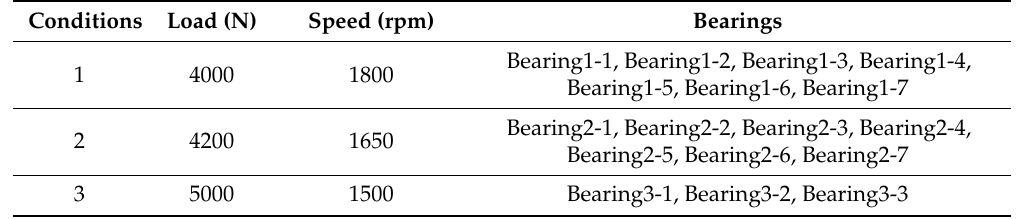
Table 2. PRONOSTIA dataset